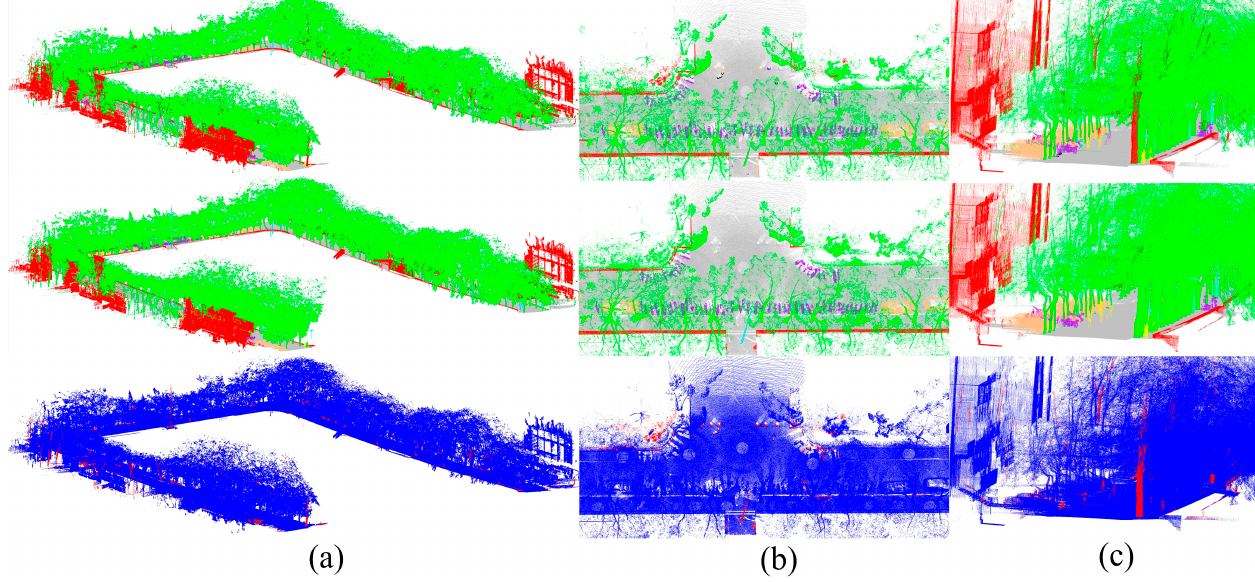
Figure 12. Classification results of the proposed method in the Wuhan University dataset. ( a ) Overall. ( b ) and ( c ) Scenes with more classified details.